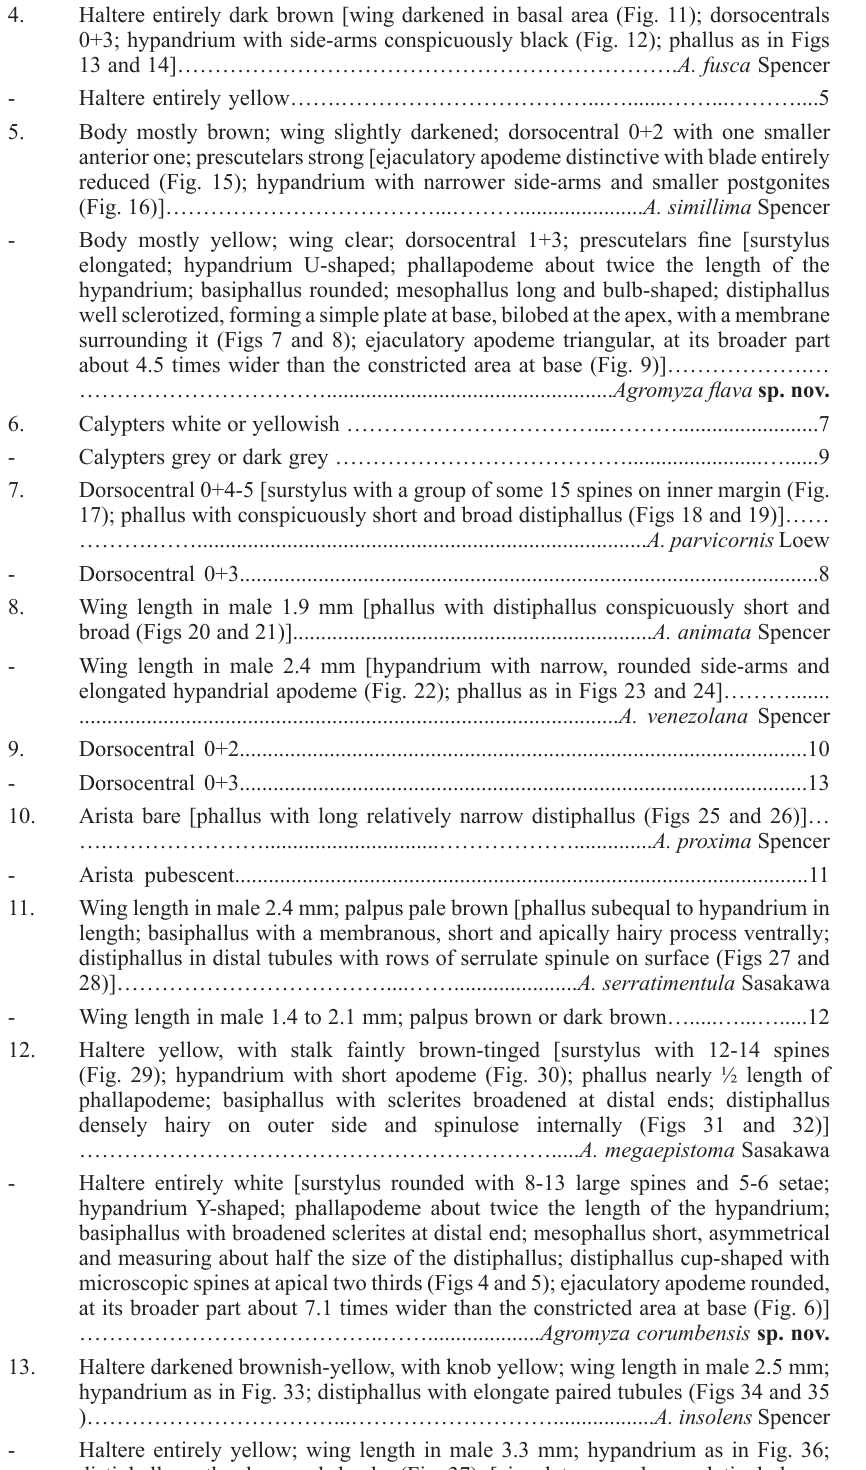
Haltere entirely yellow…….……………………………...….......……...………....5 Body mostly brown; wing slightly darkened; dorsocentral 0+2 with one smaller anterior one; prescutelars strong [ejaculatory apodeme distinctive with blade entirely reduced (Fig. 15); hypandrium with narrower side-arms and smaller postgonites (Fig. 16)]………………………………...………...................... A. simillima Spencer - Body mostly yellow; wing clear; dorsocentral 1+3; prescutelars fine [surstylus elongated; hypandrium U-shaped; phallapodeme about twice the length of the hypandrium; basiphallus rounded; mesophallus long and bulb-shaped; distiphallus well sclerotized, forming a simple plate at base, bilobed at the apex, with a membrane surrounding it (Figs 7 and 8); ejaculatory apodeme triangular, at its broader part about 4.5 times wider than the constricted area at base (Fig. 9)]……………….… 6. 7. Dorsocentral 0+4-5 [surstylus with a group of some 15 spines on inner margin (Fig. 17); phallus with conspicuously short and broad distiphallus (Figs 18 and 19)]……